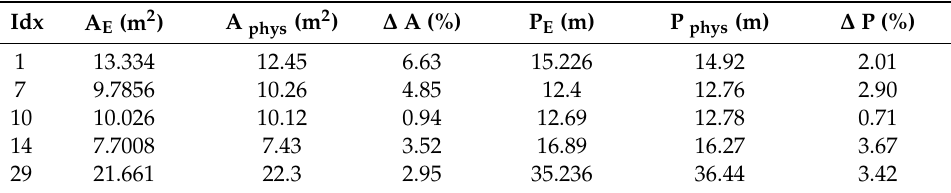
Table 6. Physical area and perimeter, di ff erence in percent (Y-axis).